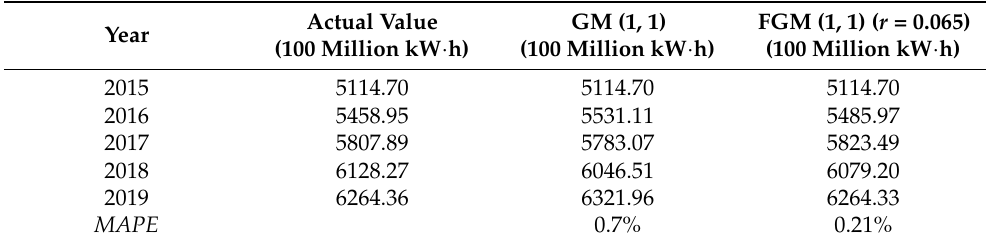
Table 1. The MAPE values of GM (1, 1) model and FGM (1, 1)